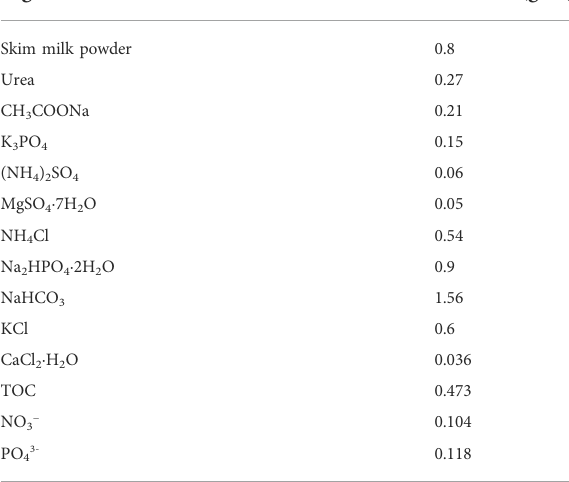
TABLE 1 Chemical composition of the synthetic dairy wastewater (SDWW).